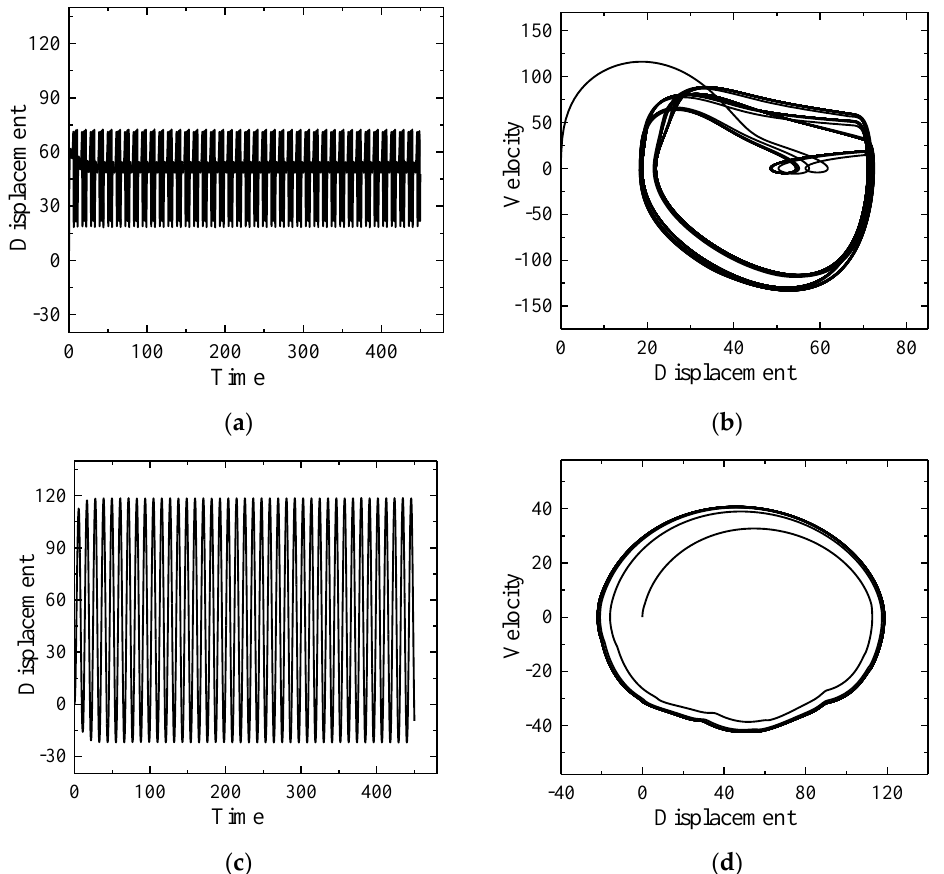
Figure 18. Evolutions of the displacement and speed-displacement diagram of brake disc and brake shoe at the braking load of 180 N. ( a ) Evolution of the displacement of the brake shoe. ( b ) Evolution of the speed-displacement diagram of the brake shoe. ( c ) Evolution of the displacement of the brake disc. ( d ) Evolution of the speed-displacement diagram of the brake disc.